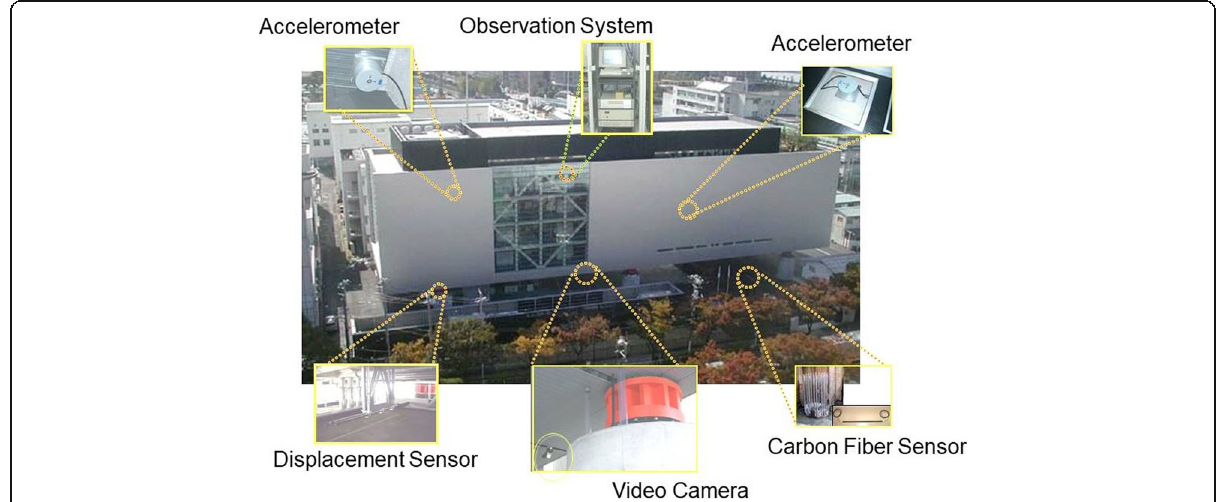
Fig. 10 Structure health monitoring